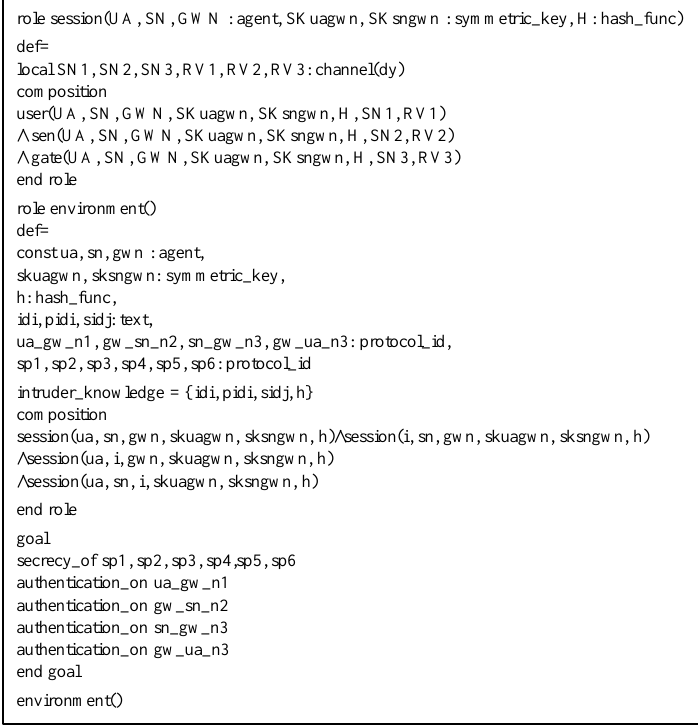
Figure 8. Role of session, environment and goal.